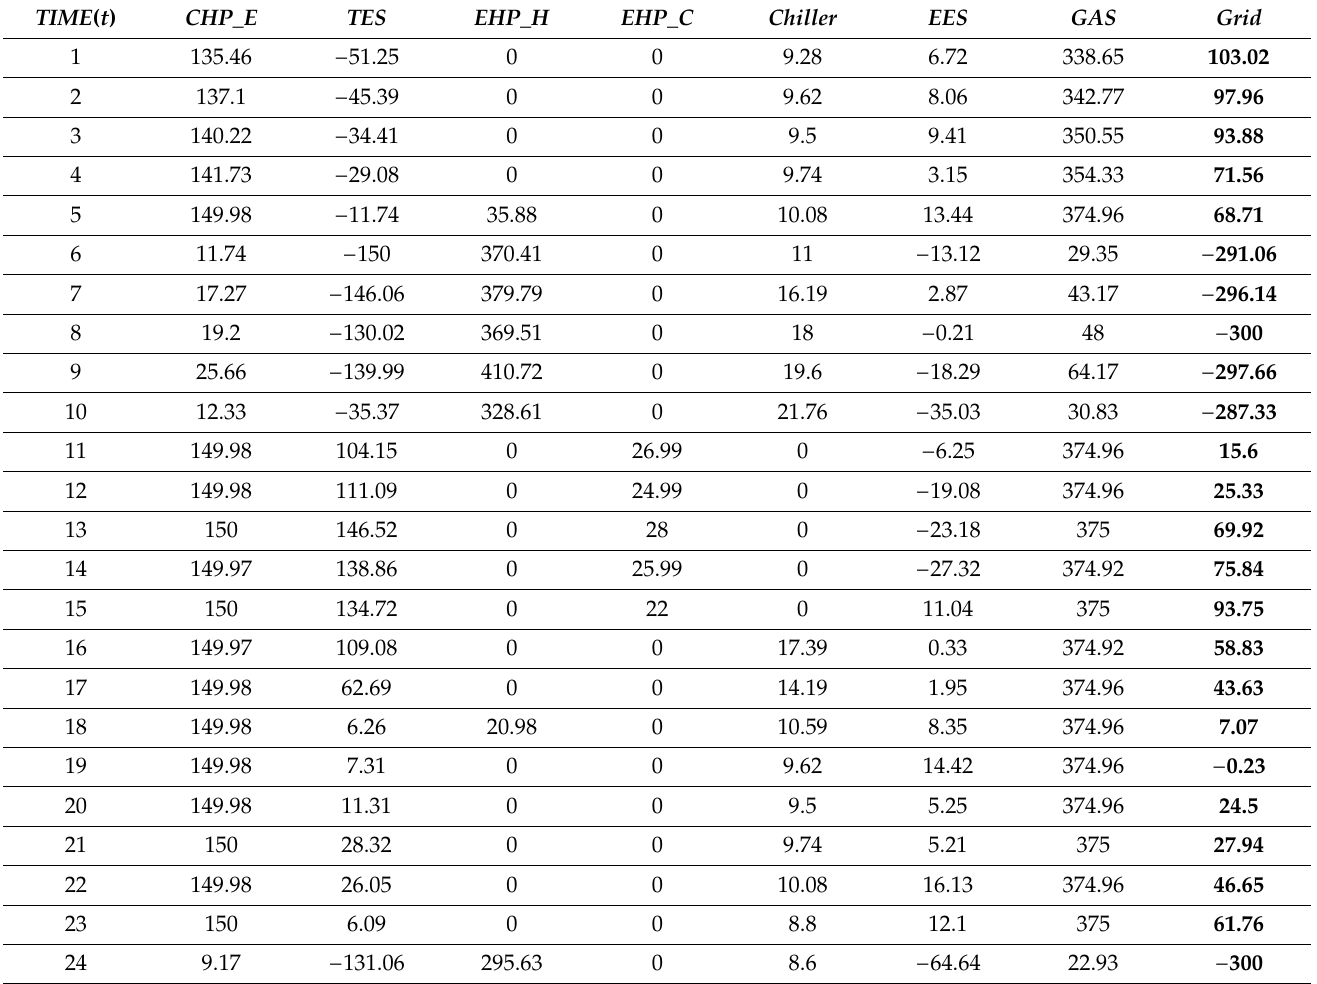
Table 7. Expected operation of energy hub evaluated using 2m + 1 method.